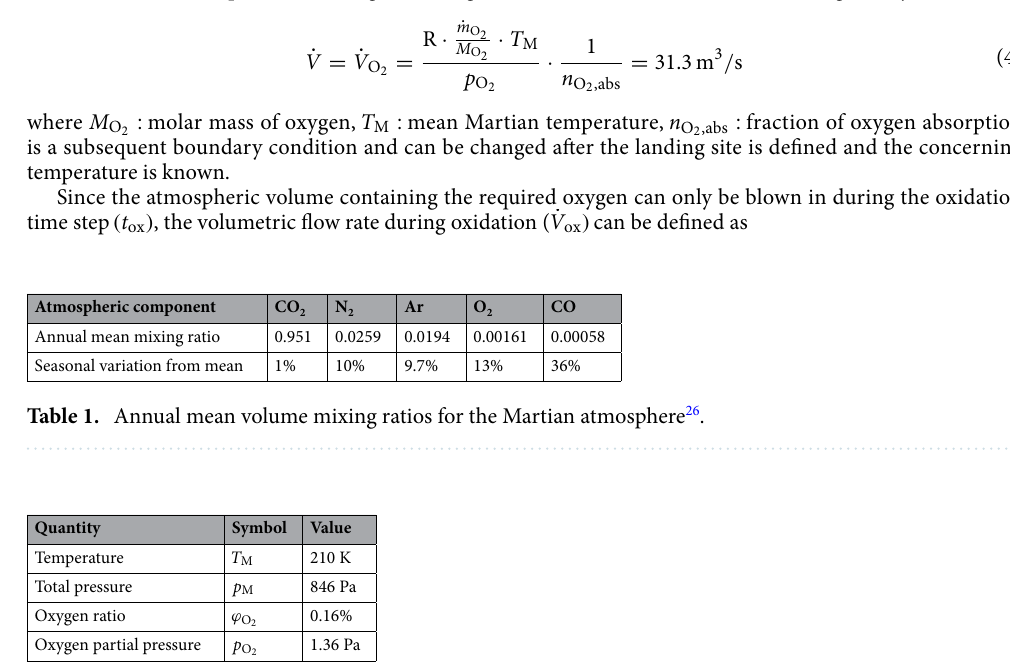
Table 2. Mean Martian atmosphere conditions used in calculations 31